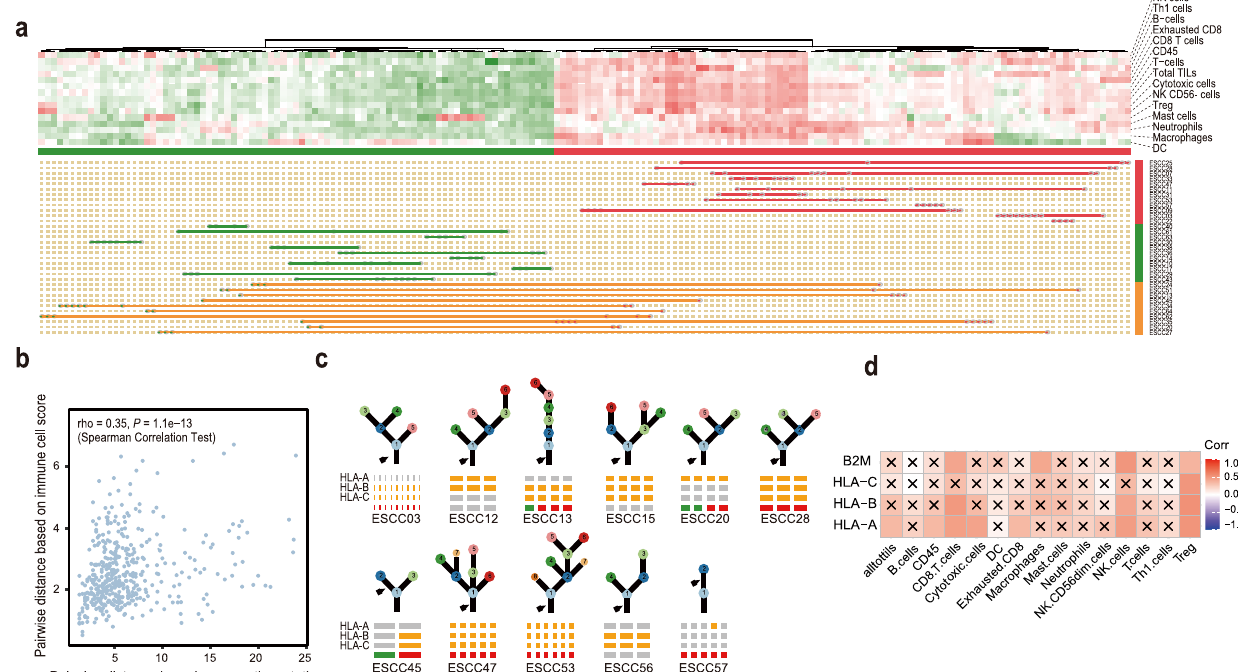
Fig. 4 | Immune in fi ltrate heterogeneity in ESCC. a The ESCC tumor samples ( n =176)areclusteredbythescoreofestimatedimmunein fi ltrate.Theimmunecell population score is estimated using the Danaher method. Each row represents a type of immune cell population. Each column represents a tumor region. Tumor regions are classi fi ed as having low levels of immune in fi ltration (low immune) are showningreen;Regionsclassi fi edashavinghighlevelsofimmunein fi ltration(high immune) are shown in red. If all the tumor regions of the same patient are in the high levels of immune in fi ltration, the patient is marked red. Patients who have